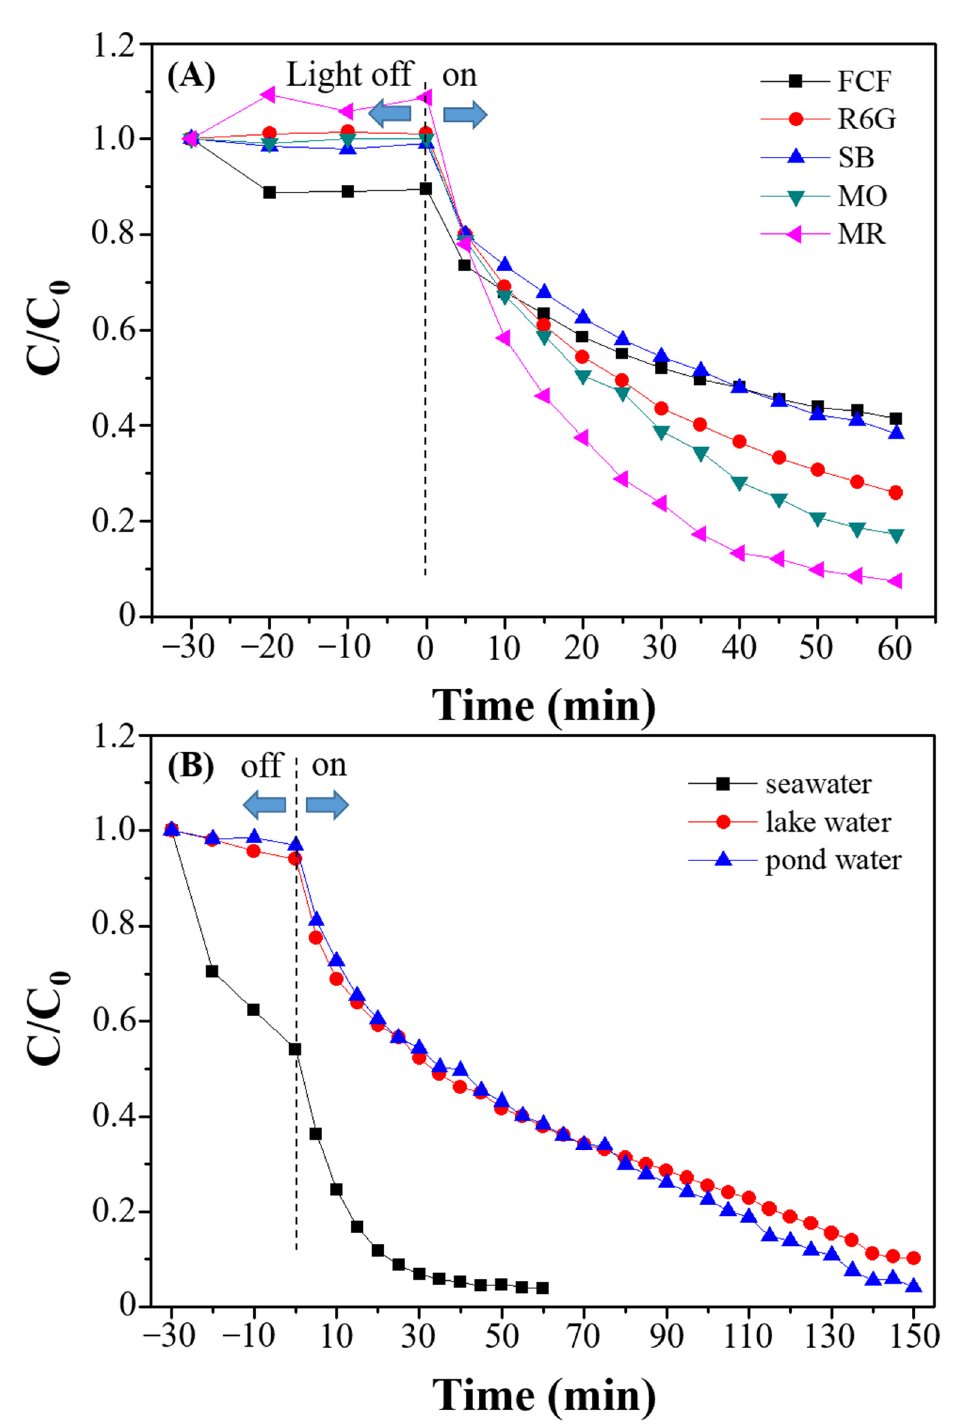
Figure 8. Photocatalytic degradation curves for ( A ) different dyestuff (FCF, R6G, SB, MO, and MR) and ( B ) MB in environmental water samples (seawater, pond water, and lake water) by CdS-ZnS-BiPO 4 nanocomposite.